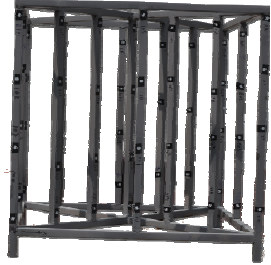
Figure 1 Standard Portable Steel